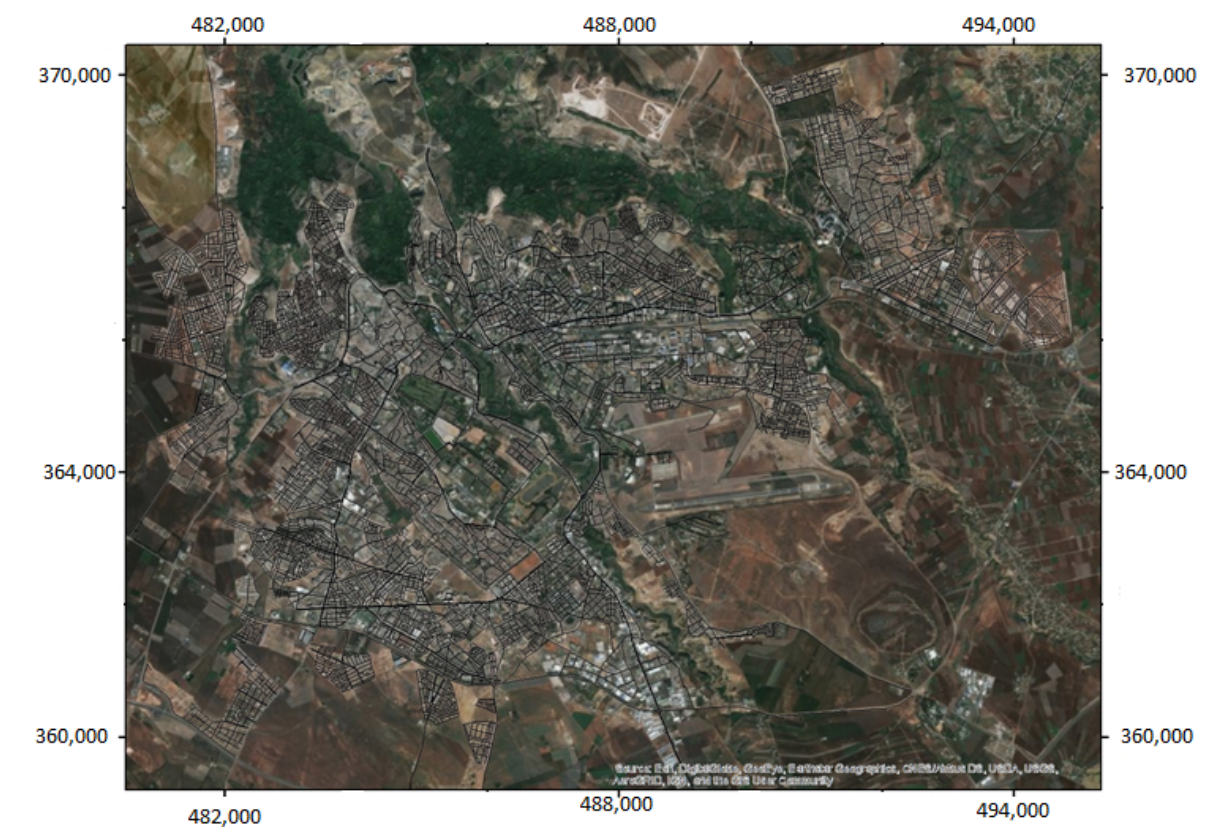
Figure 1. Location of the city of Meknes.